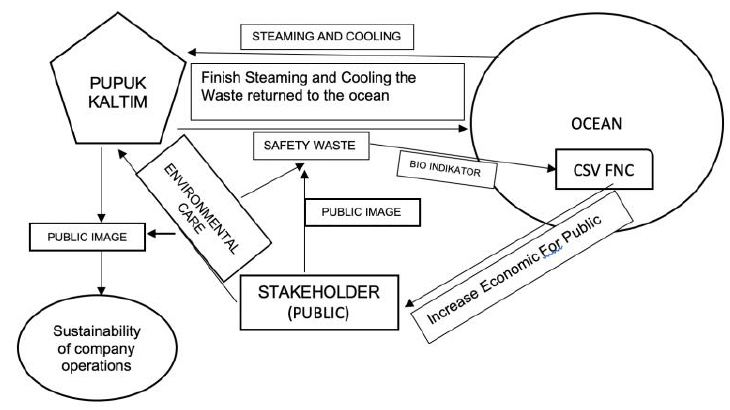
Figure 4: CSV as Public Image; Source: